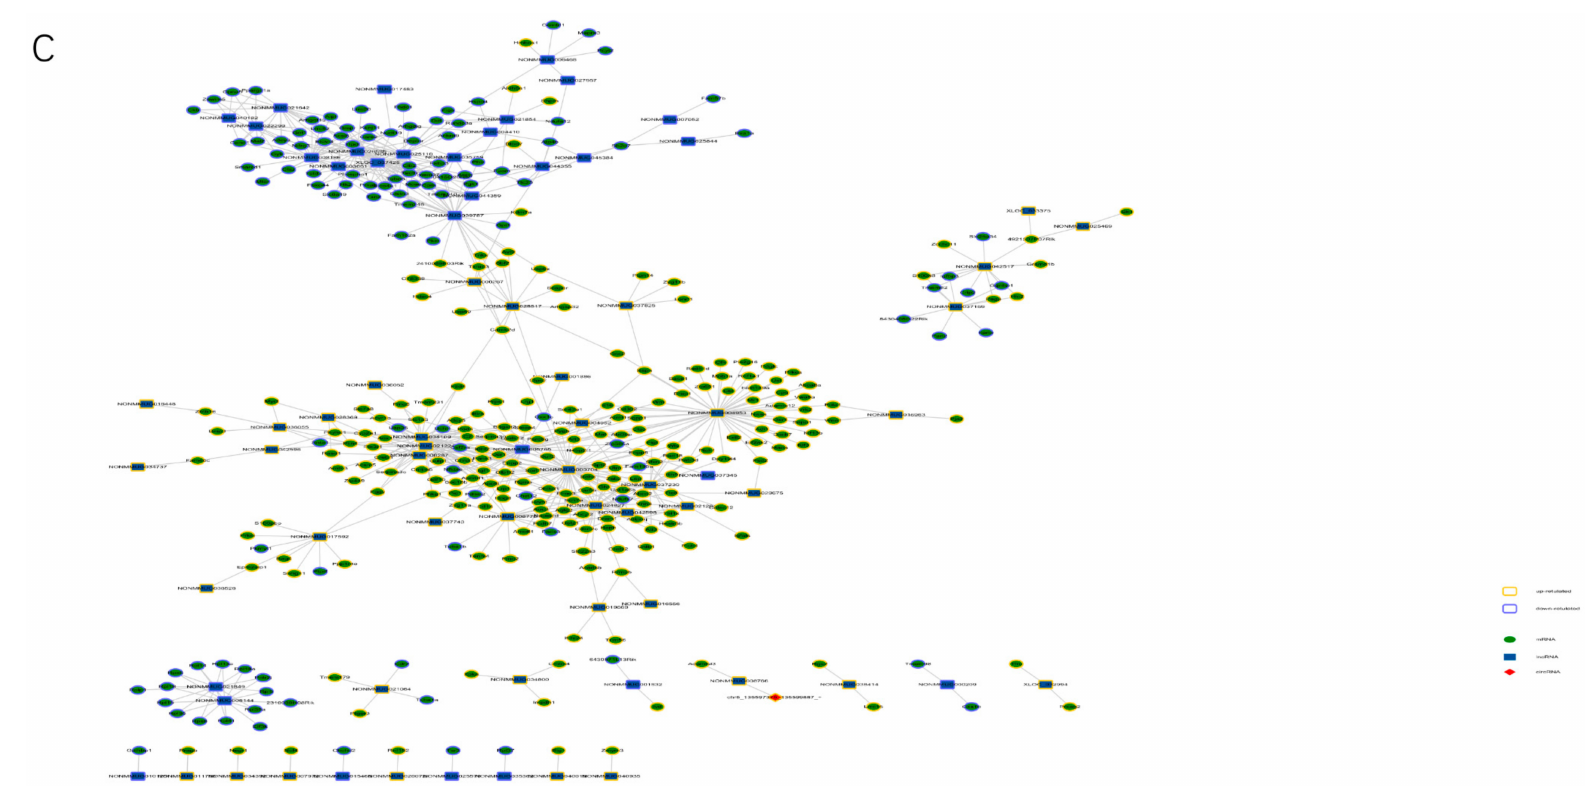
Figure 8. Competing endogenous RNA network ( A ) with mRNA, circRNA and DNA methylation regulation networks ( B , C ) in neBAT and aBAT. ( A ) The competing endogenous RNA network was based on miRNA, circRNA, and mRNA interactions. ( B ) The mRNA, circRNA, and DNA methylation regulation network was based on mRNA, circRNA, and DNA methylation interactions. ( C ) The regulation network of circRNA, lnc RNA, and mRNA in aBAT and